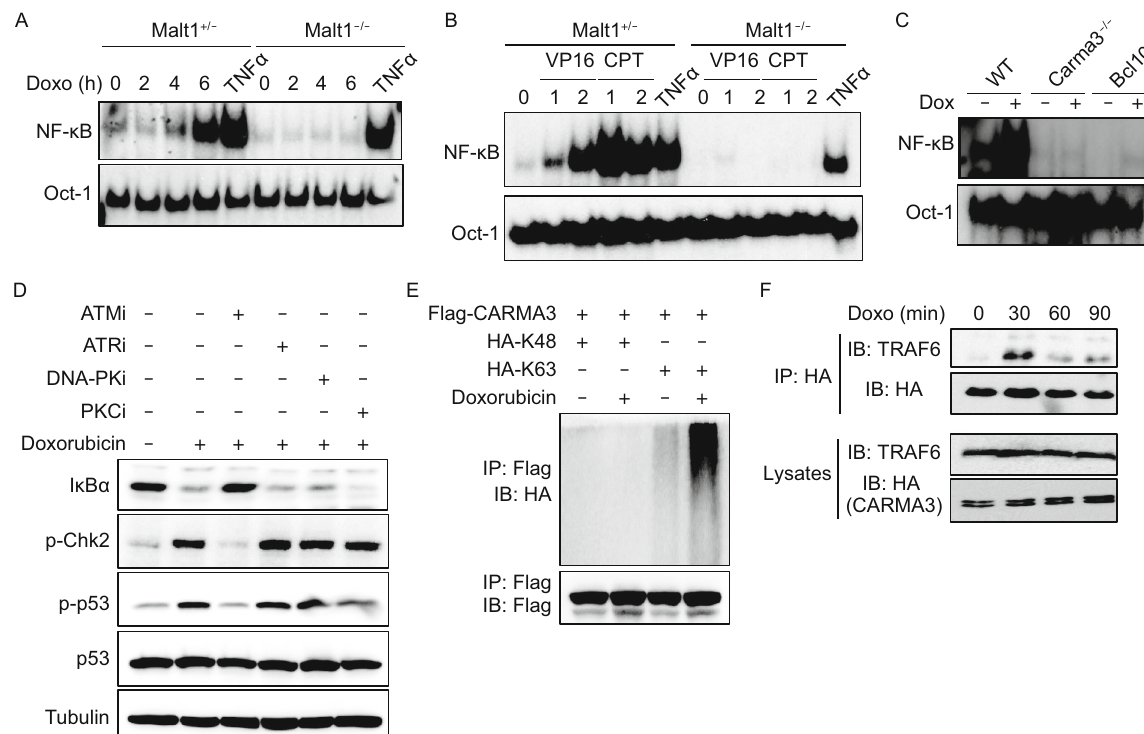
Figure 1. The CBM complex is required for DNA damage-induced NF- κ B activation by chemotherapy agents . (A) Early- passage (P1) MEFs isolated from Malt1 knockout (Malt1 − / − ) and control littermate (Malt1 +/ − ) embryos were stimulated with doxorubicin (1.5 μ g/mL) or TNF (10 ng/mL) for indicated periods. NF- κ B activation and Oct-1 levels were determined by the gel shift assay.